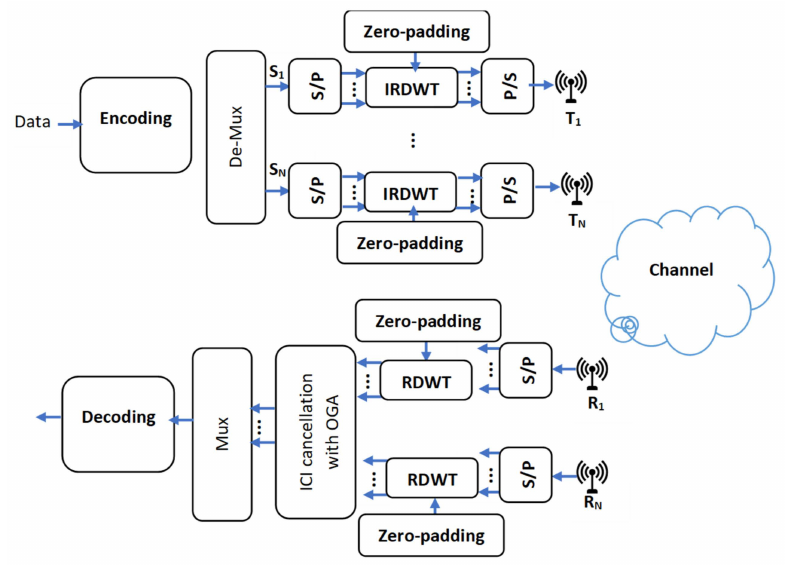
Figure 12. MIMO-RDWT-OFDM